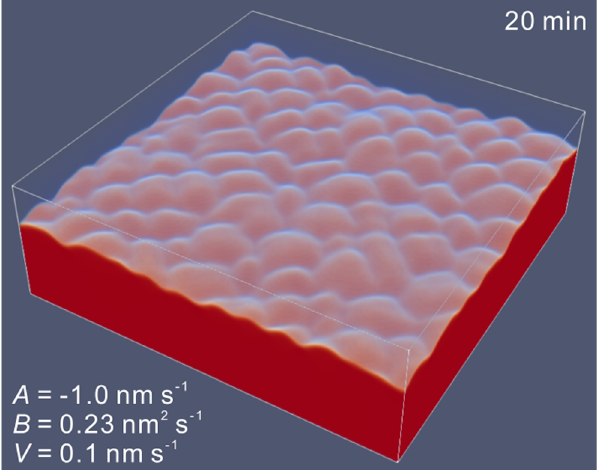
Figure 4. A typical microstructure due to the 3D phase-field simulation performed in a domain with 192 × 192 × 64 nm 3 for thin films deposited with the deposition rates of 0.1 nm s − 1 corresponding to the incident vapor rate of − 1.0 nm s − 1 and the gas–solid transition velocity of 0.23 nm 2 s − 1 at the deposition time of 20 min.